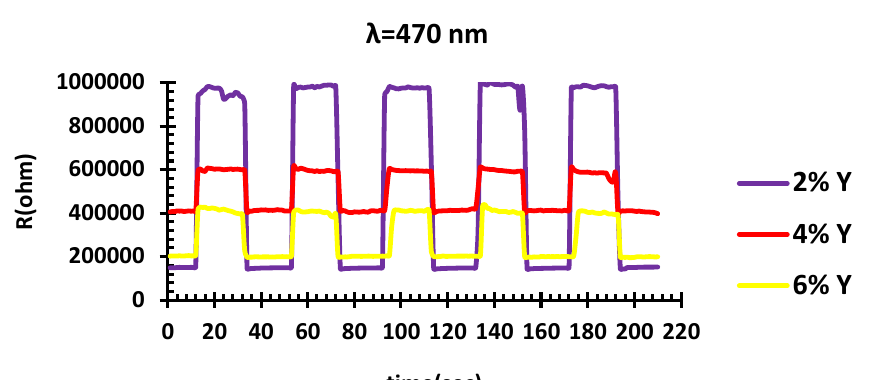
O with yttrium photo 3 4